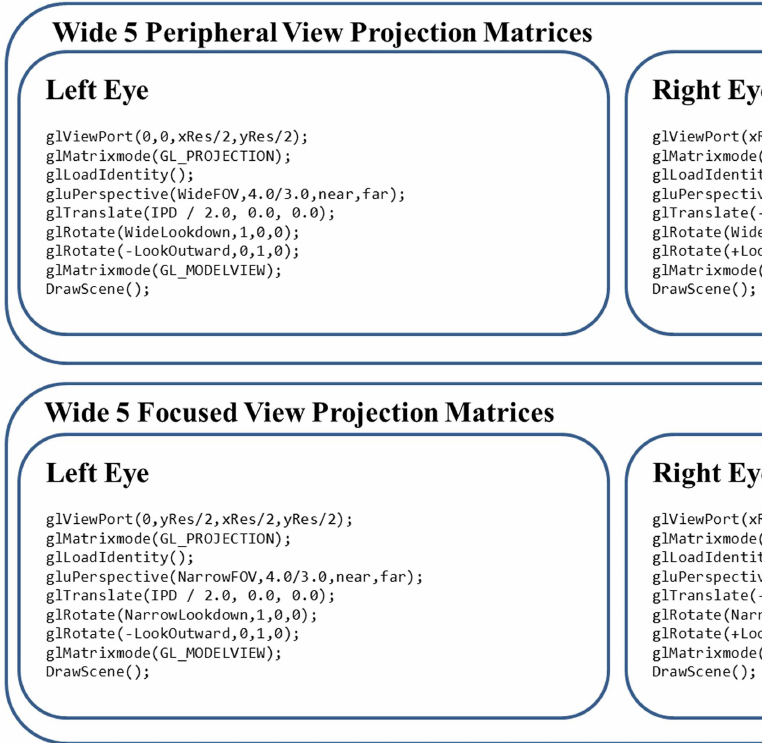
screen. According to manufacturer specifications xRes = 1600; yRes = 1200;WideFOV = 140; NarrowFOV = 80; IPD = 0.064; WideLookDown = 5.0°; NarrowLookDown = 10.0°; LookOutward = 11.25°; and we set the near and far clipping plane to 0.01 and 1000,